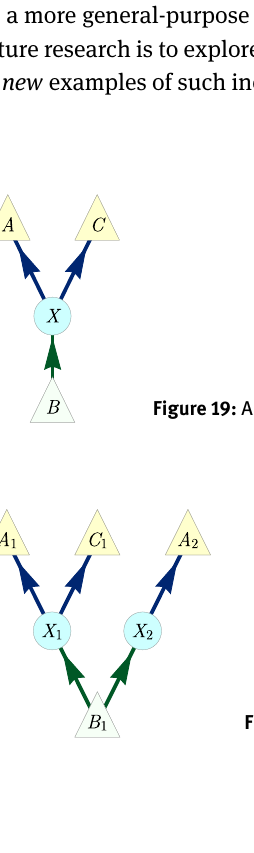
Figure 20: An inflation of